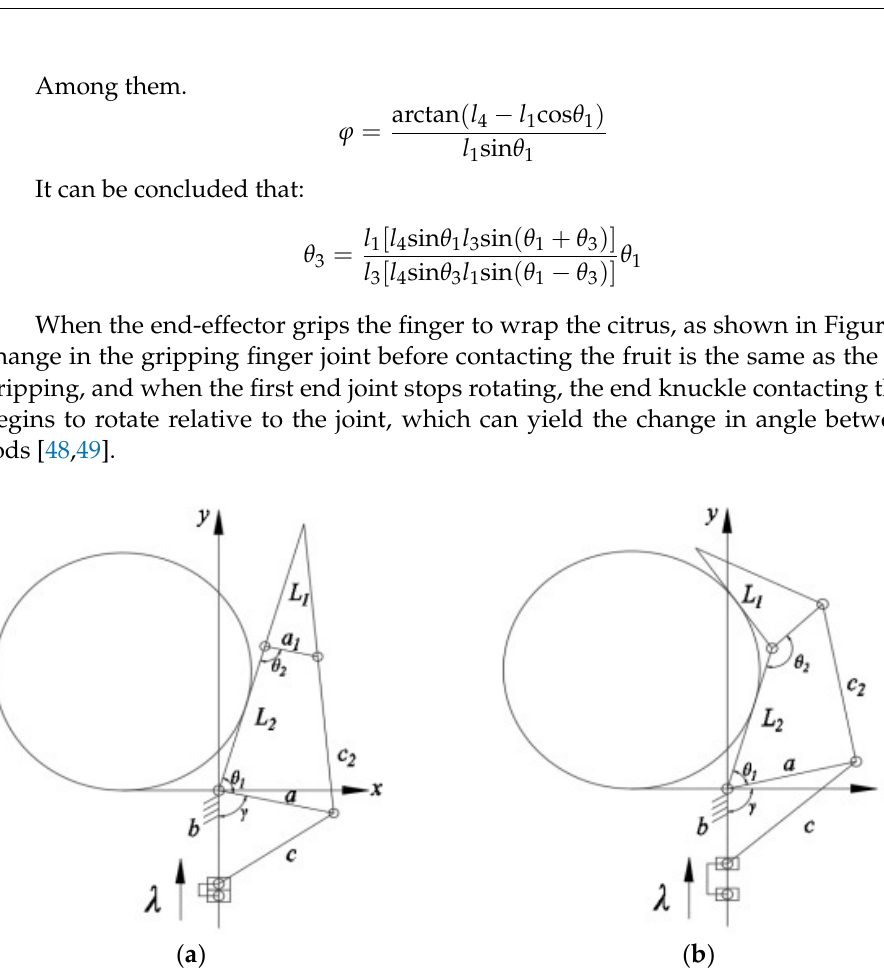
Figure 4. Sketch of clamping fingers holding fruit. ( a ) Force analysis before clamping citrus fruits ( b ) Force analysis when clamping citrus